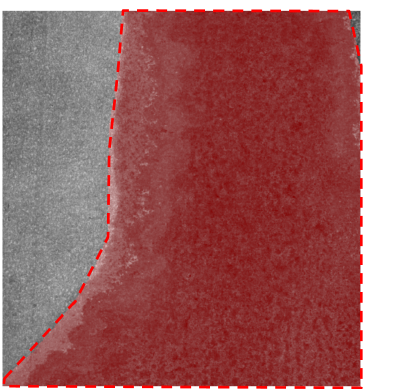
have different shapes and sizes, ideally fitting or resembling the geometry of the defects. Two samples of the texture channel with their corresponding ground truth masks in red identifying the defects are shown in Figure 4.